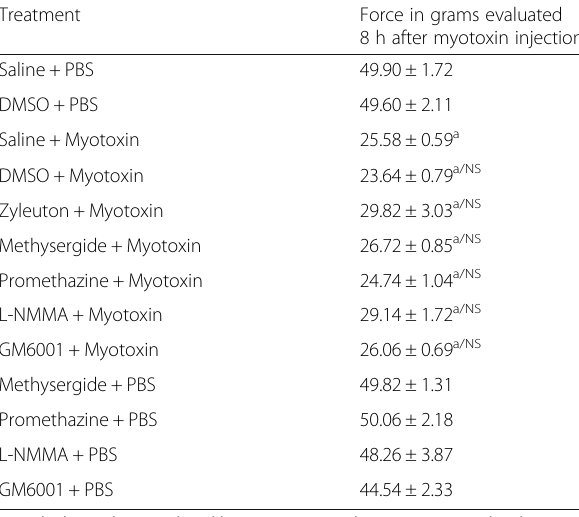
Table 2 Evaluation of histamine, serotonin, nitric oxide and metalloproteinases in the myotoxin-induced hypernociceptive effect